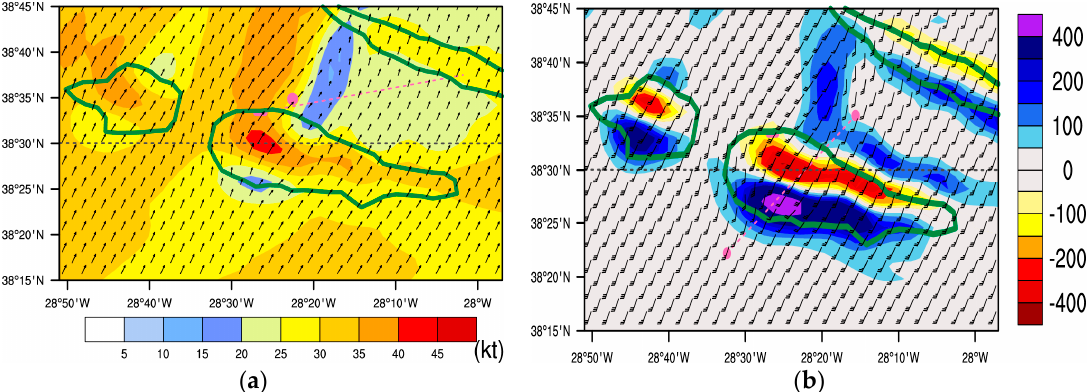
Figure 9. ( a ) Horizontal wind at 680 ft (207 m) for Flight 1; ( b ) Maximum vertical velocity under 6000 ft (1829 m) for Flight 1. Both fields are from AROME forecasts. Shading in ( a ) represents the wind speed in kt and the pink dot identifies the approximate aircraft position at this level. Pink dashed line identifies the approximate aircraft trajectory. Shading in ( b ) represents intensity in ft / min, positive values indicate upward vertical velocity and negative values represent downward vertical velocity. The pink dots are the points C and D shown in Figure 2, which are the endpoints of the cross-section (dashed pink line) used in the next figures.